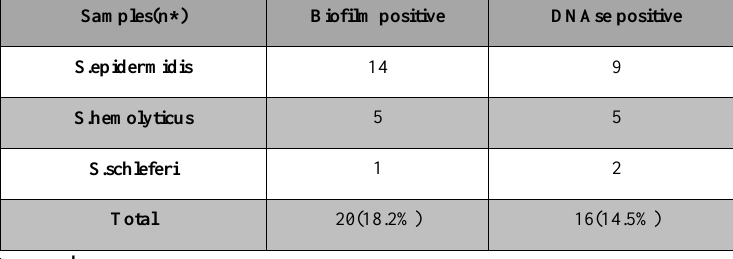
Table 4. Distribution of virulence factors among the species isolated.